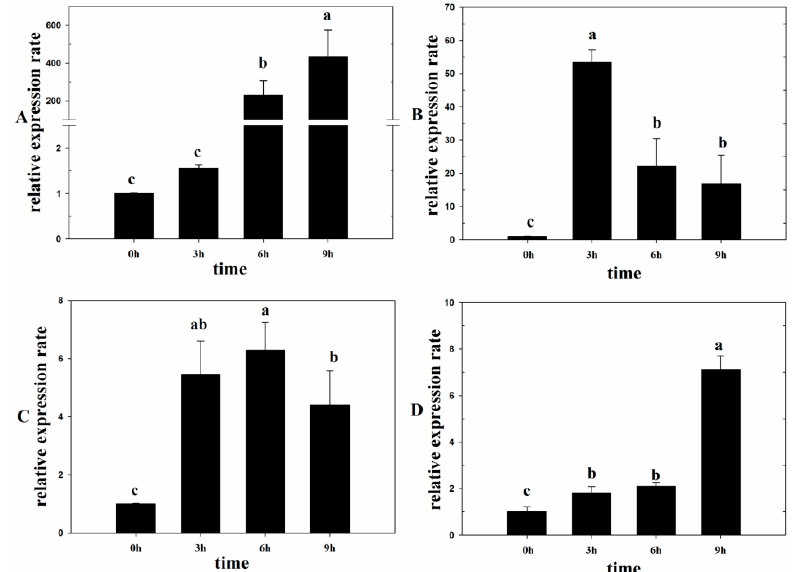
Figure 1. qPCR analysis of Lm-6-SFT in Leymus mollis plants under di ff erent treatments. ( A ) Expression of Lm-6-SFT under light conditions. ( B ) Expression of Lm-6-SFT under treatment with 5 µ M abscisic acid (ABA). ( C ) Expression of Lm-6-SFT after treatment with 50 µ M salicylic acid (SA). ( D ) Expression of Lm-6-SFT under 200 mM NaCl treatment. All experiments were repeated at least three times. Error bars indicate the standard deviation (SD). Letters represent statistically significant di ff erences between means at P < 0.05.